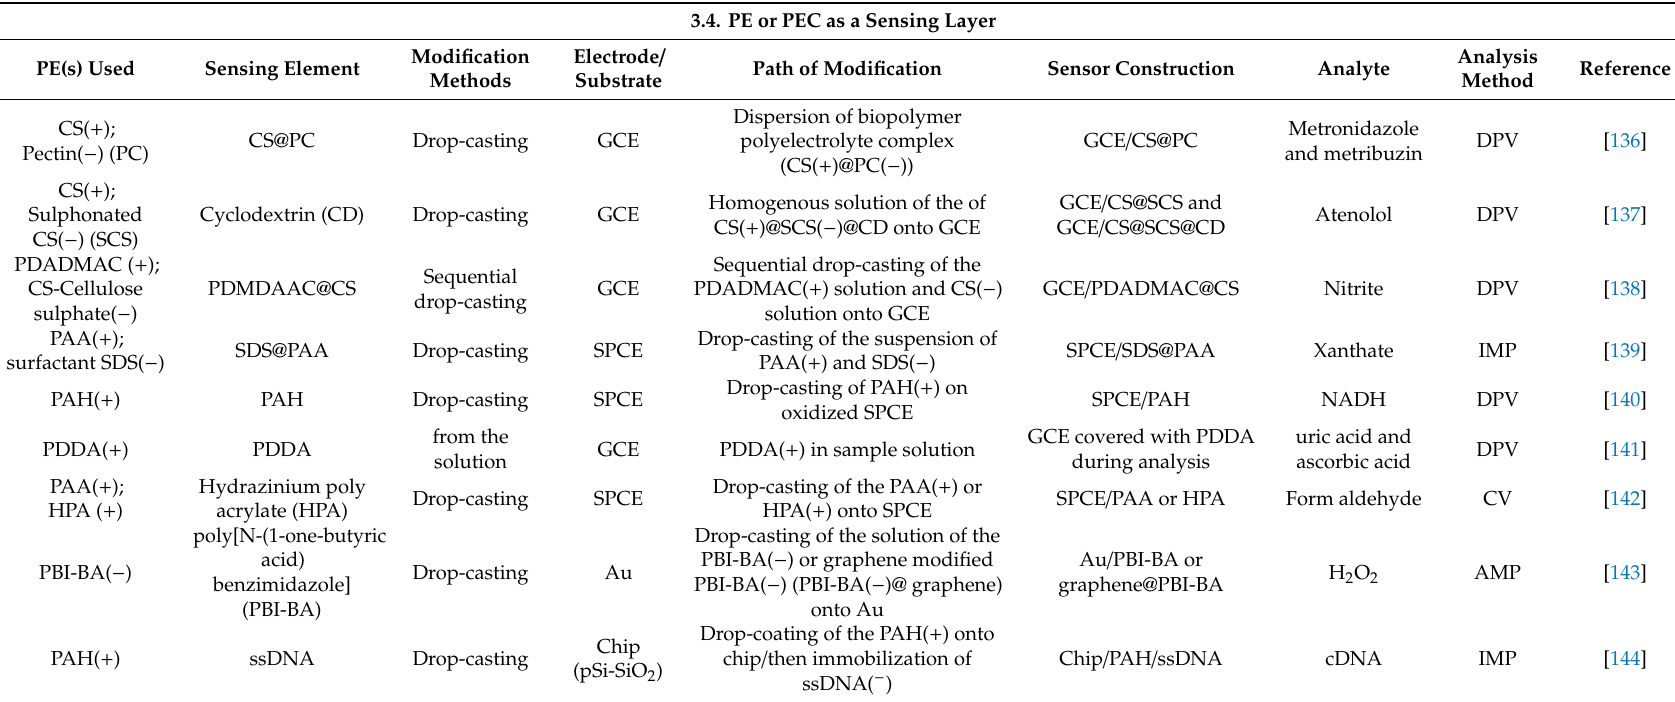
Table 8. Summary of electrochemical sensors based on the application of polyelectrolytes or polyelectrolyte complexes as sensing